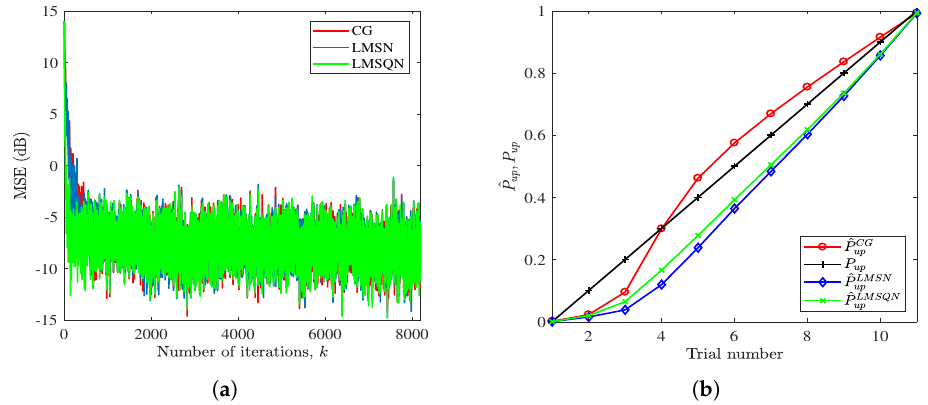
Figure 4. Simulation 2: ( a ) Learning curves for the data selection and ( b ) Comparison between the desired P up and achieved ˆ P LMSN up , ˆ P LMSQN up and ˆ P CG up by the data-selection algorithms.